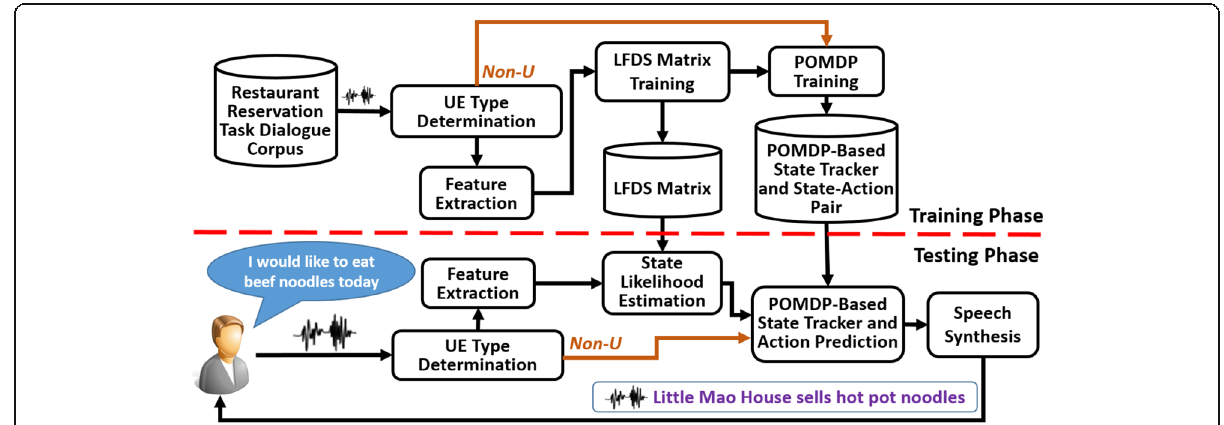
Fig. 2 The framework of the proposed spoken dialogue system